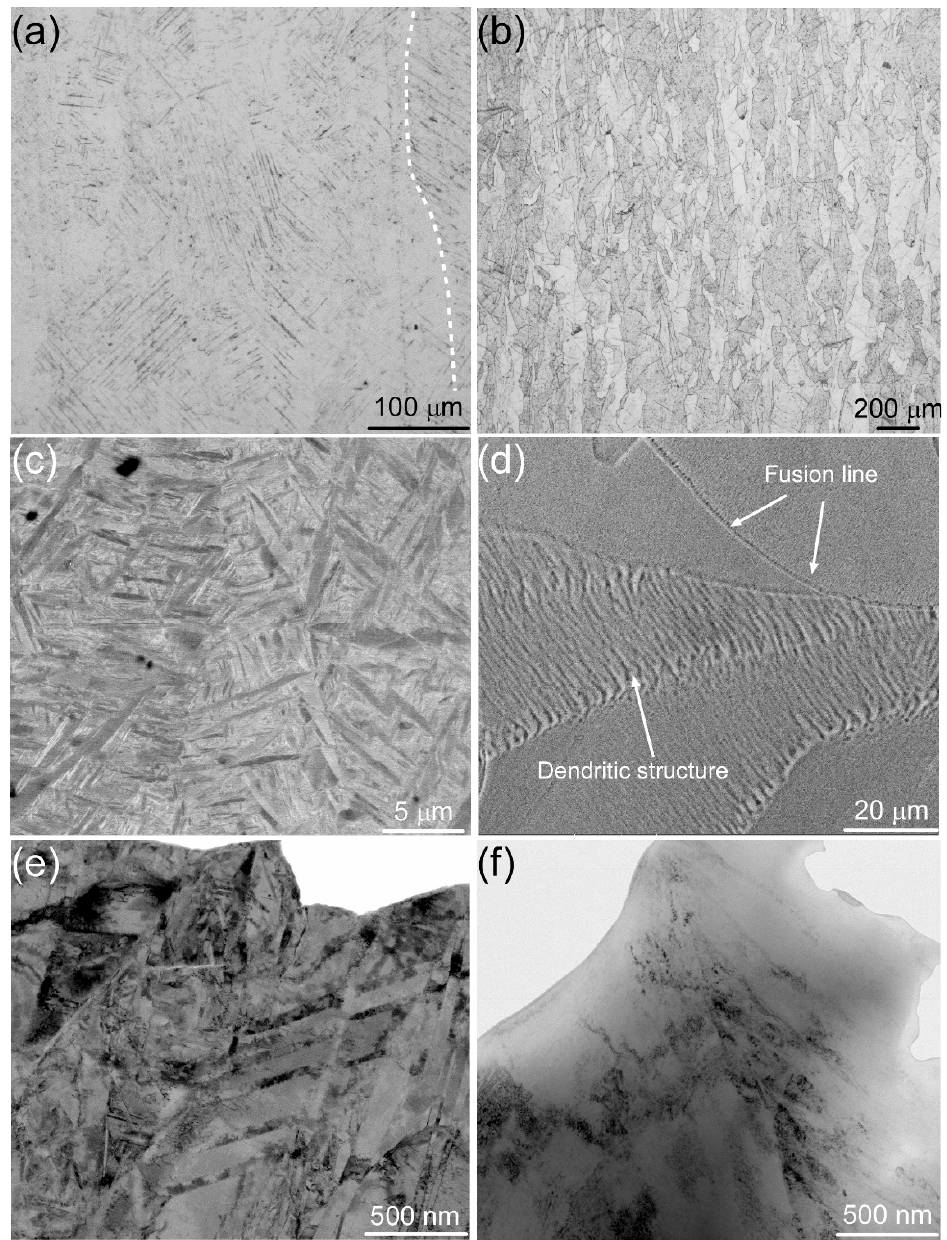
Figure 4. Optical microscopy (OM) images showing the columnar prior β grains on the vertical plane of ( a , b ) for Ti64 and Ti55511 samples, respectively. ( c , d ) are the SEM backscattered electron images of Ti64 and Ti55511 samples. ( e , f ) are the TEM images of Ti64 and Ti55511 samples.